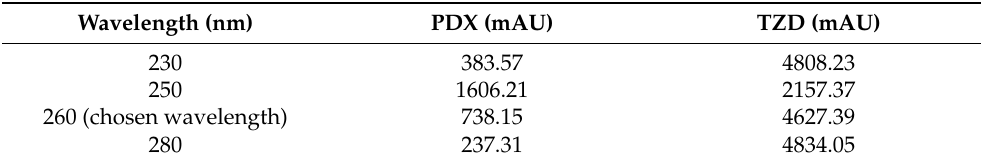
Table 5. Outline of the detected AUC values for PDX and TZD after deliberate adjustments in the detection wavelength obtained during the injection of a solution containing 100 µ g/mL PDX and TZD,